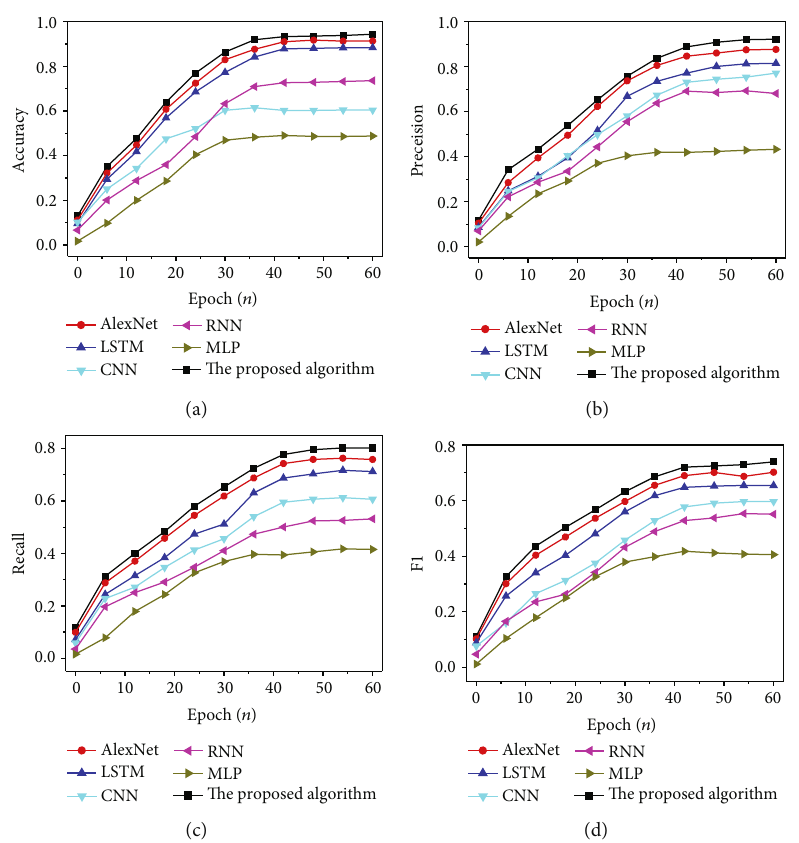
Figure 6: In fl uence curve of classi fi cation prediction accuracy with the increase of iteration times under di ff erent algorithms ((a) Accuracy; (b) Precision; (c) Recall; (d) F1 value).